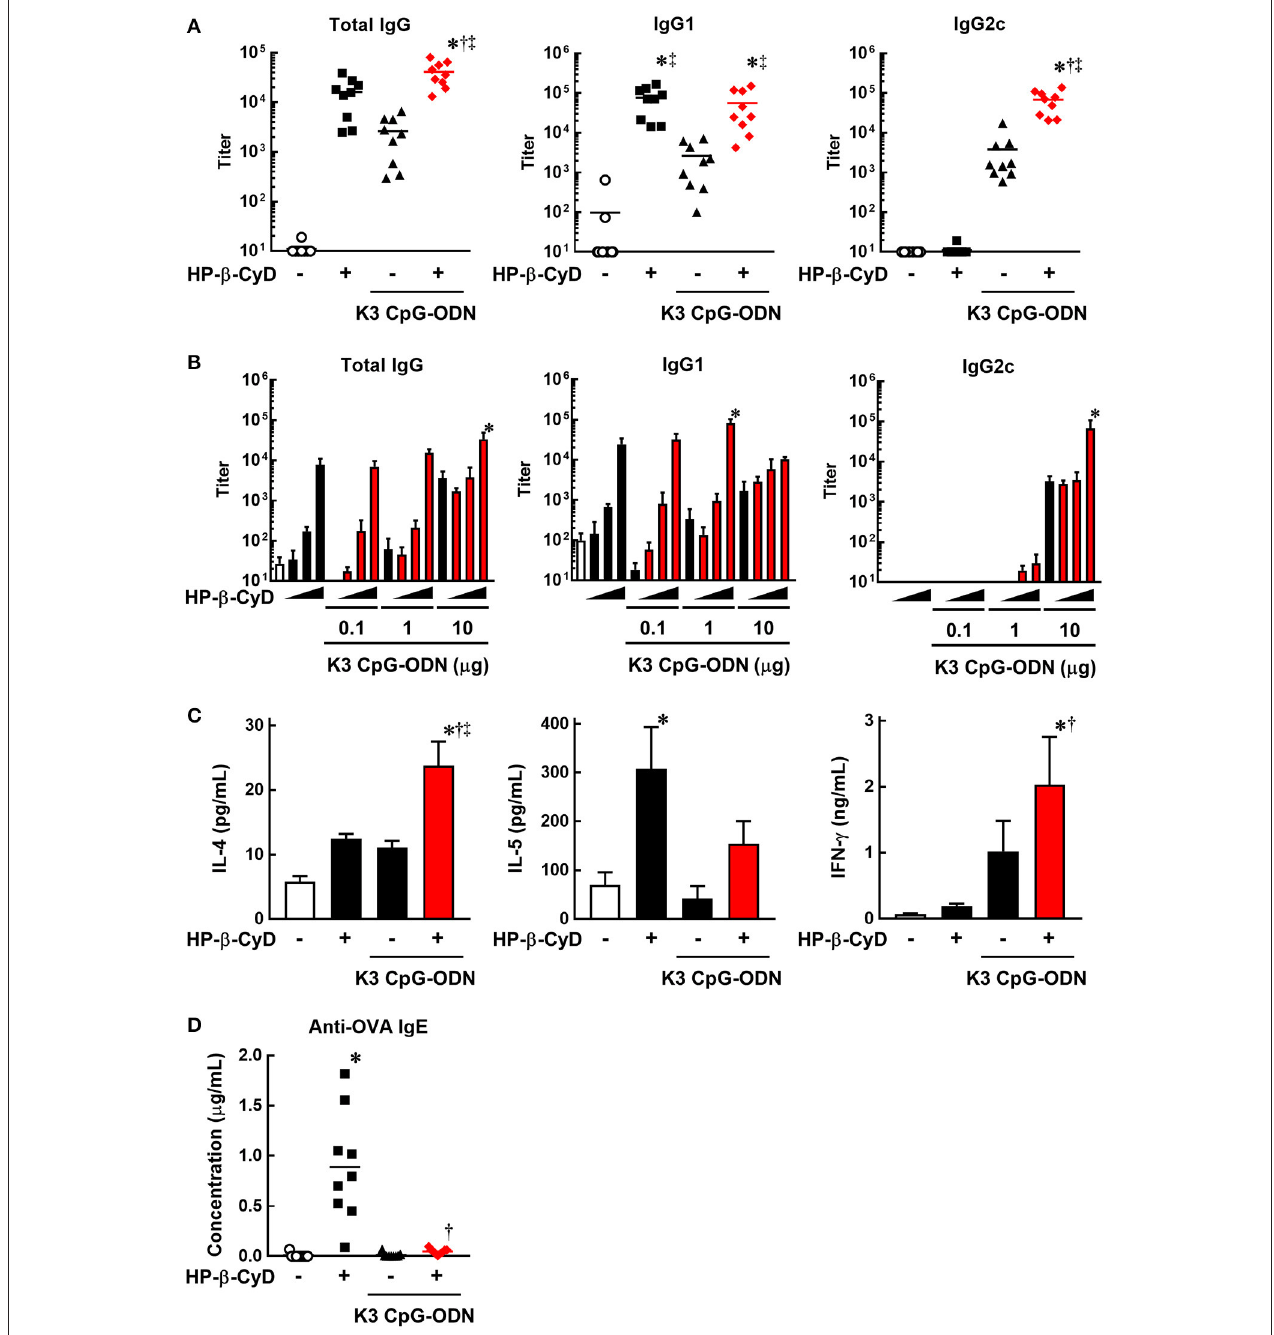
FIGURE 1 | Combination of HP- β -CyD and K3 CpG-ODN induces both type-1 and type-2 responses in parallel with suppressed production of IgE. (A–D) C57BL/6 mice were inoculated with 3 µ g of OVA in PBS containing (A) 30% HP- β -CyD and 10 µ g of K3 CpG-ODN or (B) 3, 10, or 30% HP- β -CyD and K3 CpG-ODN (0.1, 1, or 10 µ g) into the base of the tail on day 0 and 14. Blood was collected 7 days after the boost. Anti-OVA total IgG, IgG1, IgG2c (A) and IgE (C) were determined by ELISA. (A,C) Each dot represents an individual mouse ( n = 8–9 per group in 2 independent experiments). (B) Each value represents the mean ± S.E. ( n = 3–4 per group, representative data of two independent experiments). (C) Seven days after the second immunization, splenocytes were collected and cultured under stimulation with OVA (10 µ g/mL). After 48h, the concentrations of IL-4, IL-5, and IFN- γ in the medium were measured by ELISA. Each value represents the mean ± S.E. ( n = 6 per group in two independent experiments). (A–D) * p < 0.05 compared with OVA alone, † p < 0.05 compared with OVA + HP- β -CyD, ‡ p < 0.05 compared with OVA + K3 CpG-ODN (one-way ANOVA with Bonferroni’s multiple comparison test).